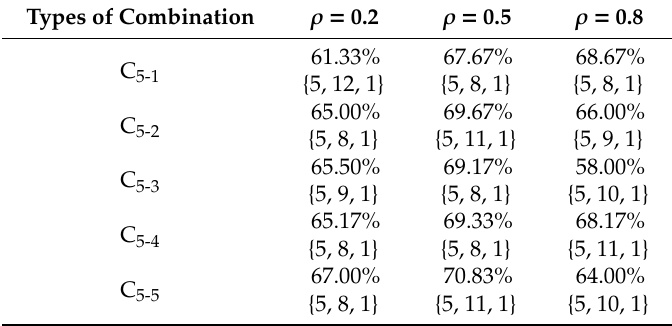
Table 4. Artificial neural network (ANN) identification results, AIR -ANN {A ni , A nh , A no }, for ten combinations of faults of an MNP